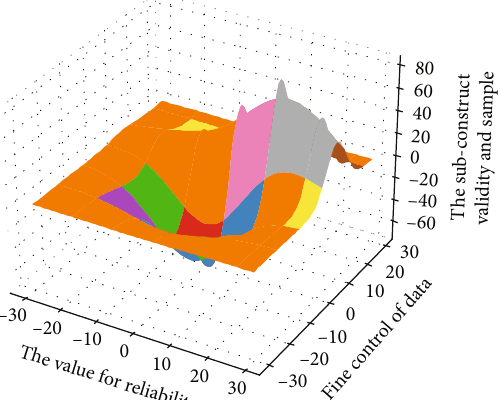
Figure 10: Construct validity and reliability of fi ne control